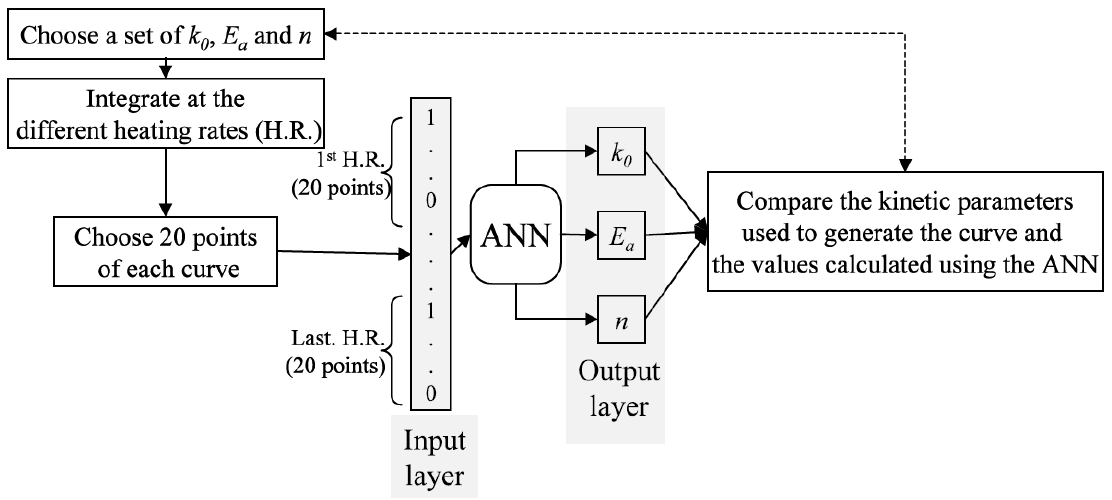
Figure 12. The framework of thermokinetic analysis with ANN proposed in Ref. [56]. Reprinted with permission from Elsevier.